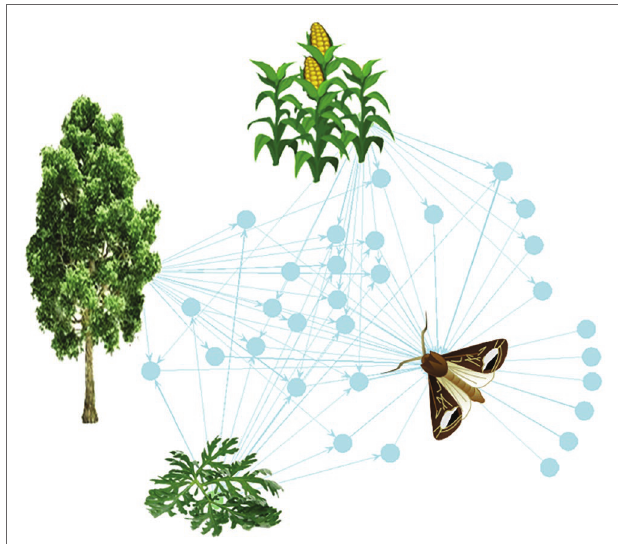
FIGURE 1 | The plant-VPC-insect network. The complex odorscape of a moth ( Agrotis ipsilon ) shown as a communication network between plants, VPCs, and insect spaces. The network graph is based on the chemical analyses of plant VPCs and recordings of EAG responses from the literature (Greiner et al., 2002; Jerkovic et al., 2003; Degen et al., 2004; McCormick et al., 2014). It has been drawn using the R package “network” (R Core Team, 2013). The plant species release VPCs (blue spots) that are detected by the olfactory system of the moth. The information contained in VPCs circulates from the plants to the insect (blue arrows). Each plant emits a variety of VPCs and one VPC can be produced by different plant species. For simplification, the VPCs not detected by the moth have been omitted. The olfactory system of the moth detects VPCs released by its host plant, maize, as well as by companion plants, such as a weed ( Artemisia vulgaris ) and trees surrounding the fields ( Populus nigra ). Most of the VPCs are shared between two or three plants. This simplified network does not take into account the intensity of the emissions, which can largely differ among VPCs released by a same plant, and moreover varies according to the biomass of individual plants and of the whole plant